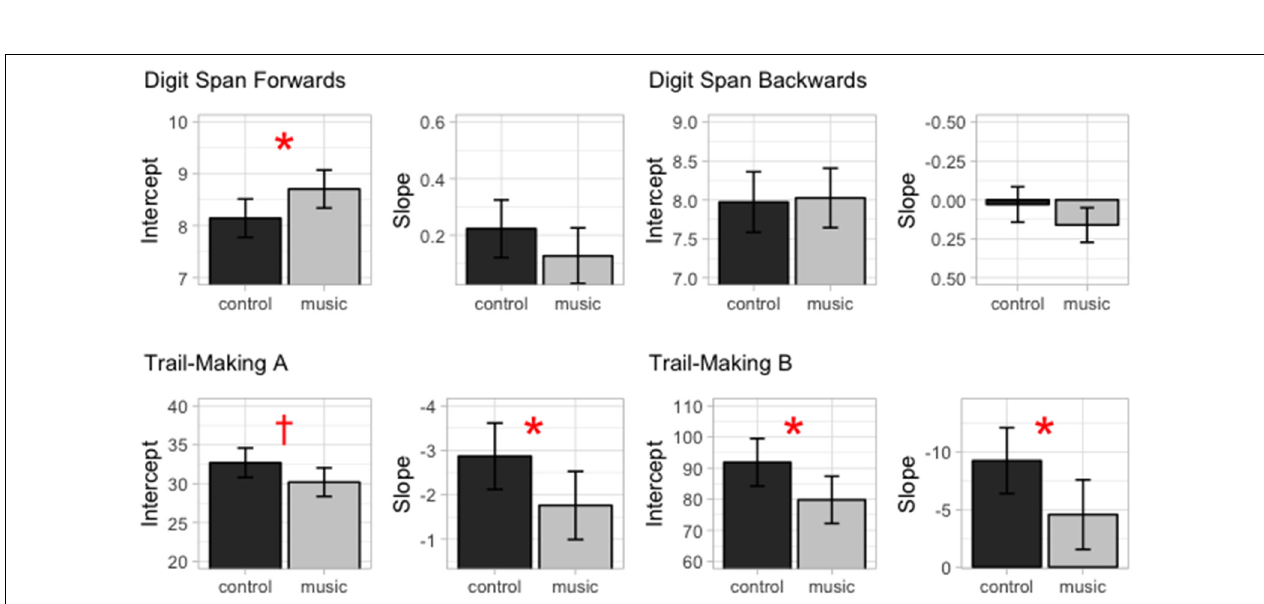
FIGURE 2 | The intercepts (i.e., estimated performance at mean age) and slopes (i.e., estimated change in performance with age) for each test separately for the Music and Control groups. The errorbars indicate 95% confidence intervals. ∗ p < 0.05, † p = 0.07.